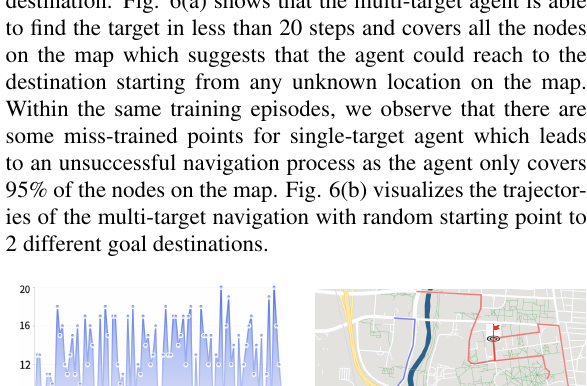
Figure 7. (a) The navigation route learned for a single-target agent. The vehicle and the flag represent the starting point and the target correspondingly. (b) The stop sign represents road closure and follows the number order.